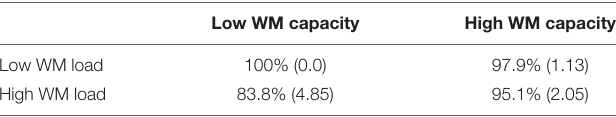
TABLE 3 | Mean percentage (and SEs) of trials in which target word was correctly selected and digits were correctly